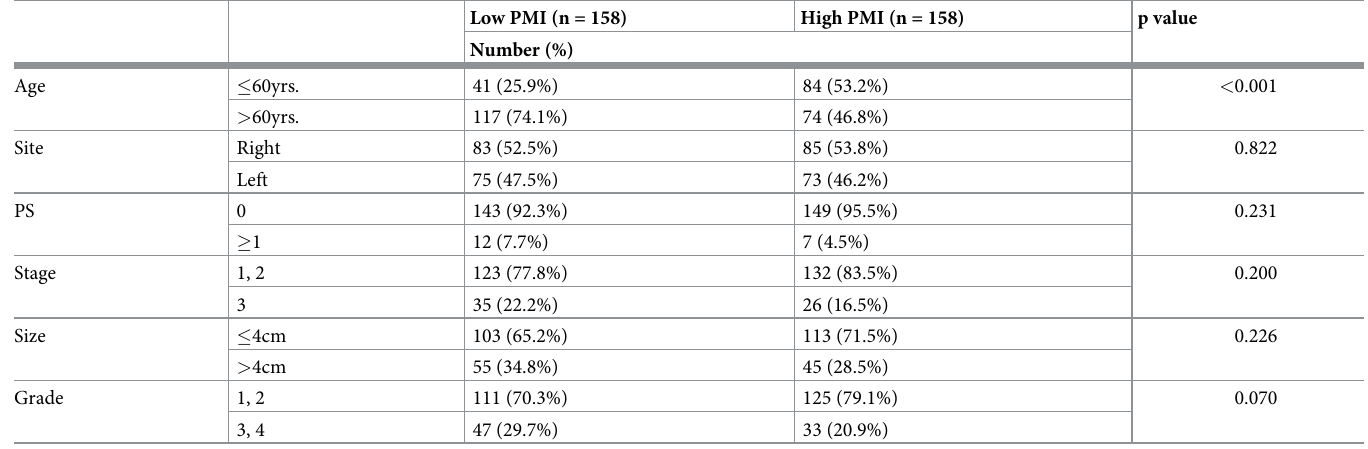
Table 2. Psoas muscle index and